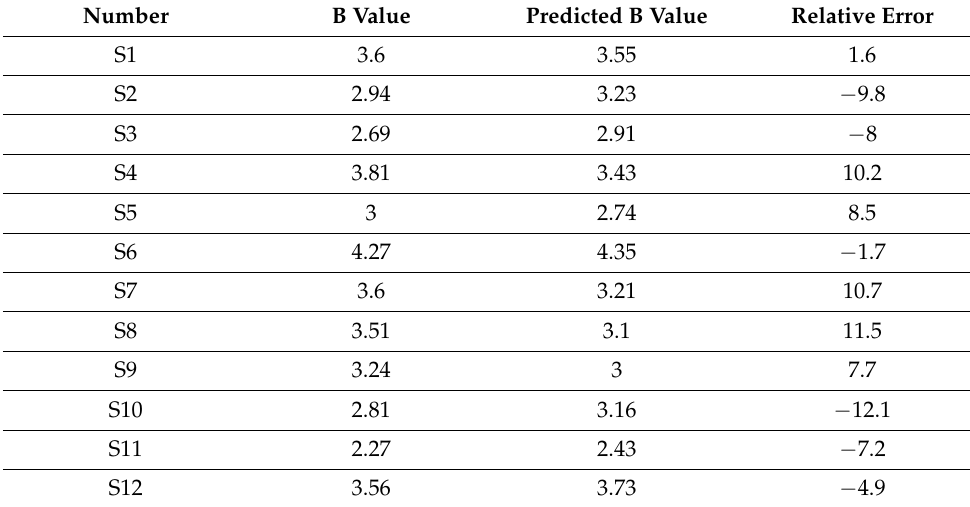
Table 10. Attenuation rate B value